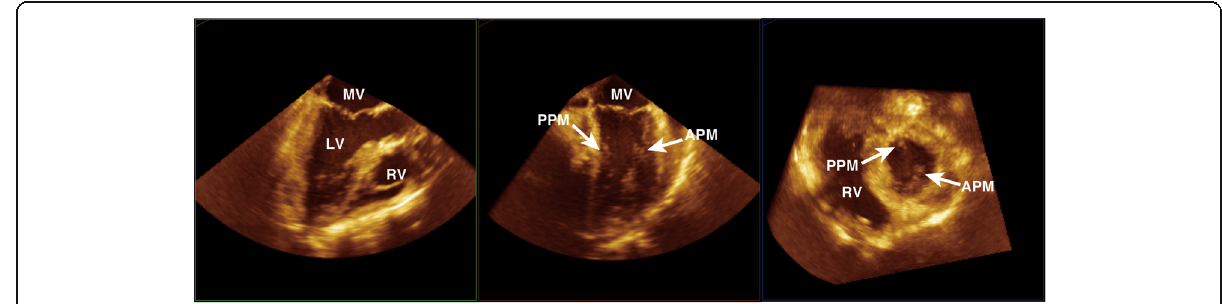
Fig. 5 Mid-esophageal long axis view (left), mid-esophageal mitral commissural view (middle), and short axis view of the left ventricle (right). These images were obtained thorugh multiplanar reconstruction from a volume dataset after weaning from cardiopulmonary bypass. The morphology of the mitral valve and posteromedial papillary muscle is normal. APM anterolateral papillary muscle, LV left ventricle, MV mitral valve, PPM posteromedial papillary muscle RV right